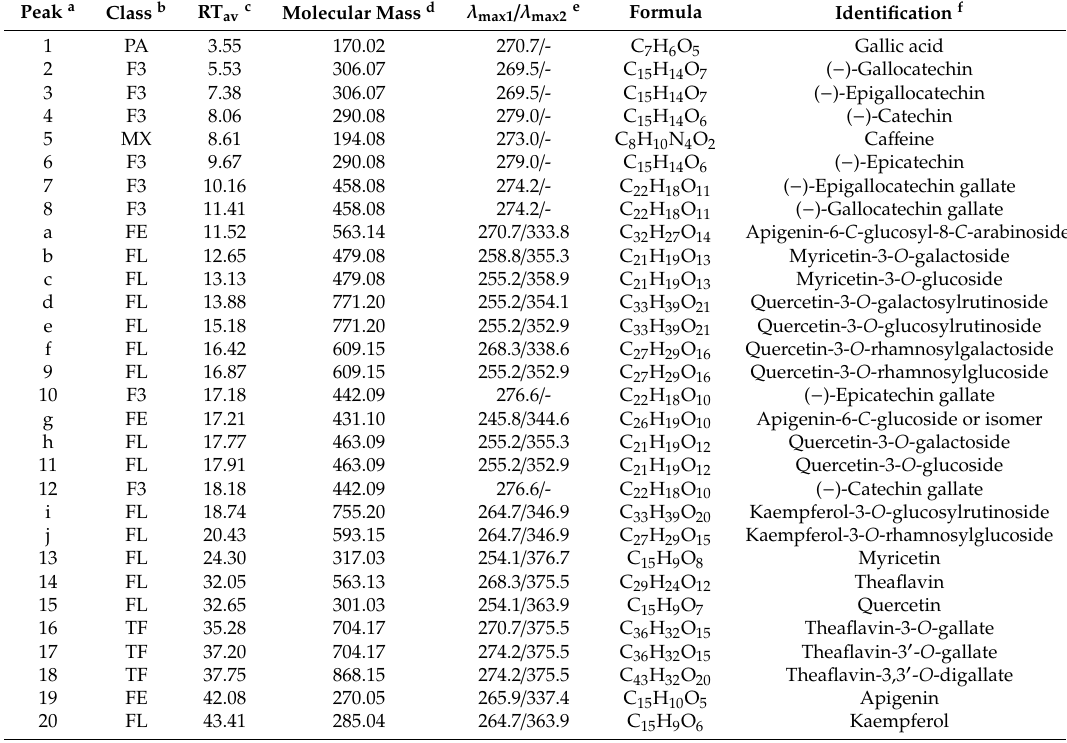
Table 1. Identification of compounds in the five tea